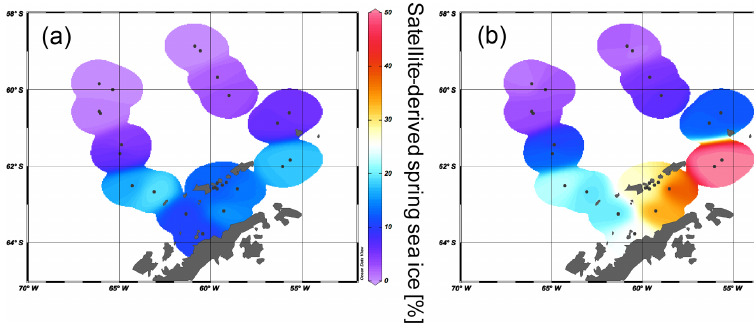
Figure 4. The satellite-derived mean sea ice concentrations at each sampling station for (a) spring and (b)